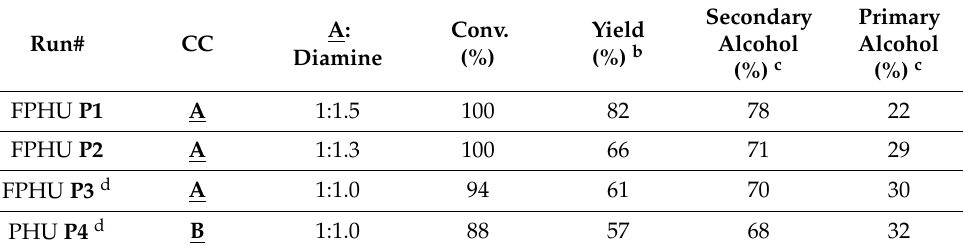
Table 3. FPHUs and PHUs synthesis from ( A ) or ( B ) with hexamethylenediamine a